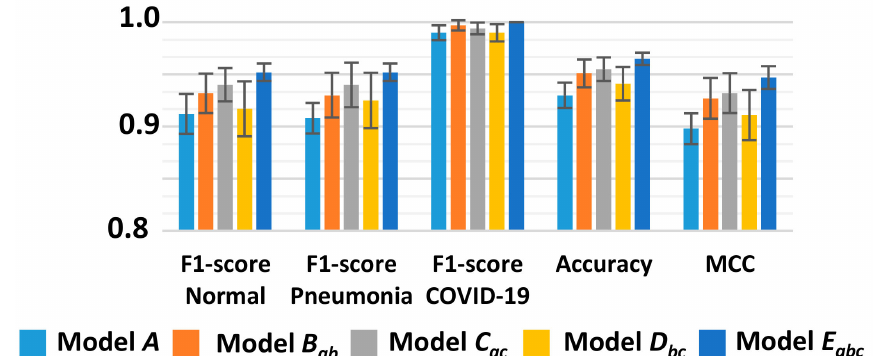
Figure 5. Classification performance (mean) graph that represents F1-score of normal, pneumonia, and COVID-19, accuracy, and MCC for each model using 41 new COVID-19 images (uploaded in the GitHub https: // github.com / ieee8023 / covid-chestxray-dataset from 16 April 2020 to 5 May 2020). The error bar represents the standard